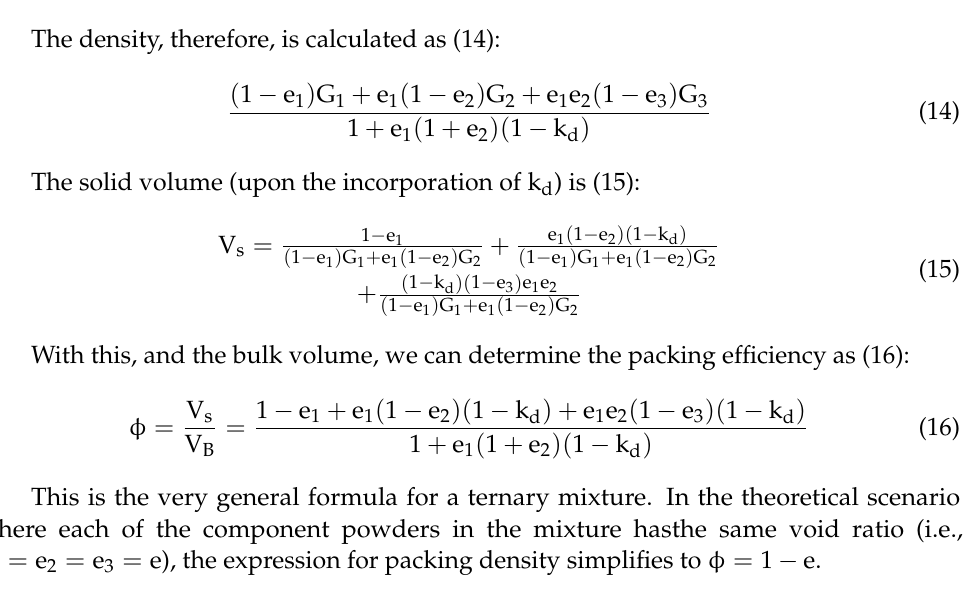
Figure 5. A graph of the volume reduction factor (vertical axis) vs. the ratio of consecutive sizes, k (horizontal axis).